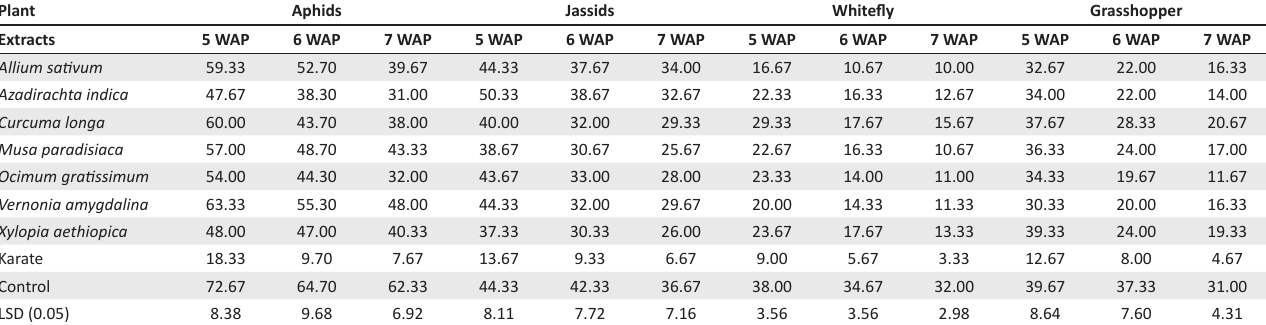
TABLE 3: Mean population densities of insects on mung bean treated with plant extracts and karate in 2016 cropping season. Plant Aphids Jassids Whitefly